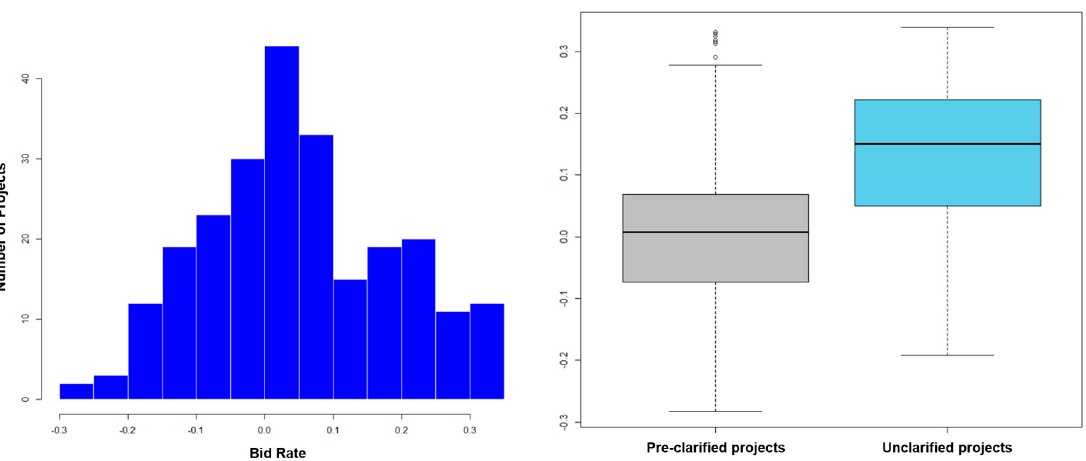
Figure 2. Distribution of bid price relative to estimated cost between pre-clarified projects and unclarified projects.